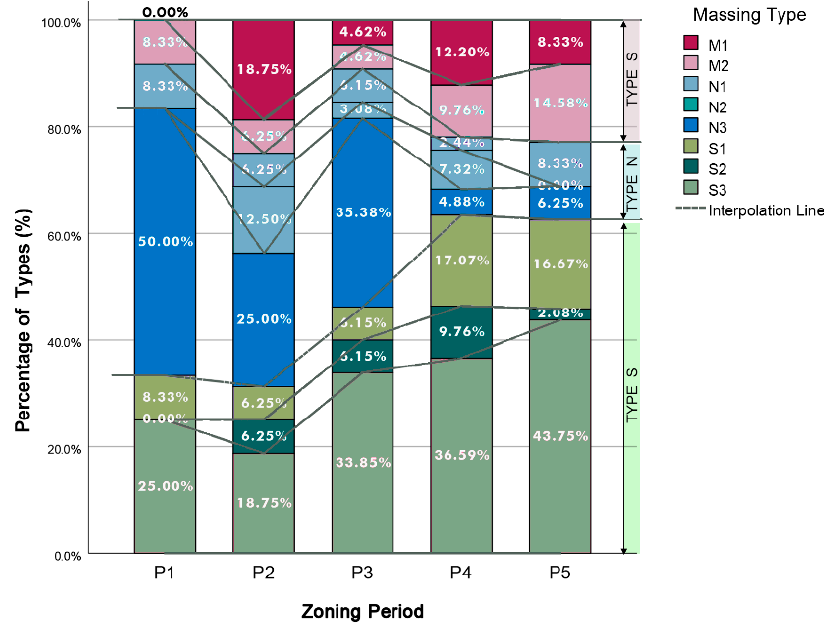
Figure 15. Percentage of each type per zoning period.